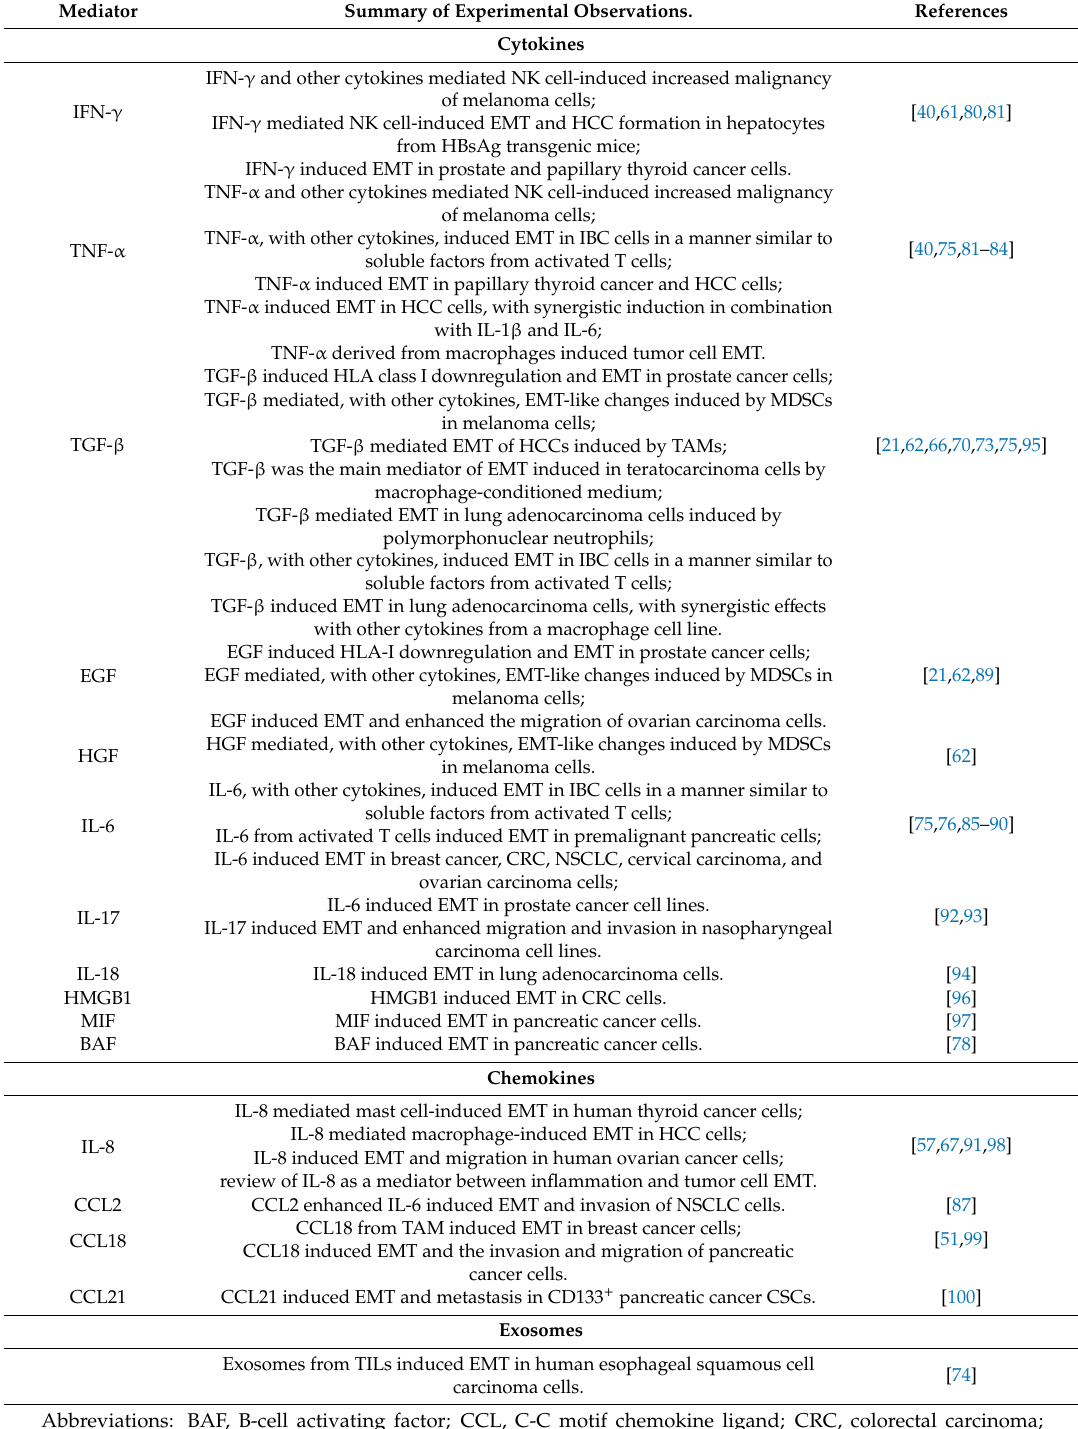
Table 3. Mediators (soluble mediators or exosomes) of the induction of EMT by cells of the immune system. Mediator Summary of Experimental